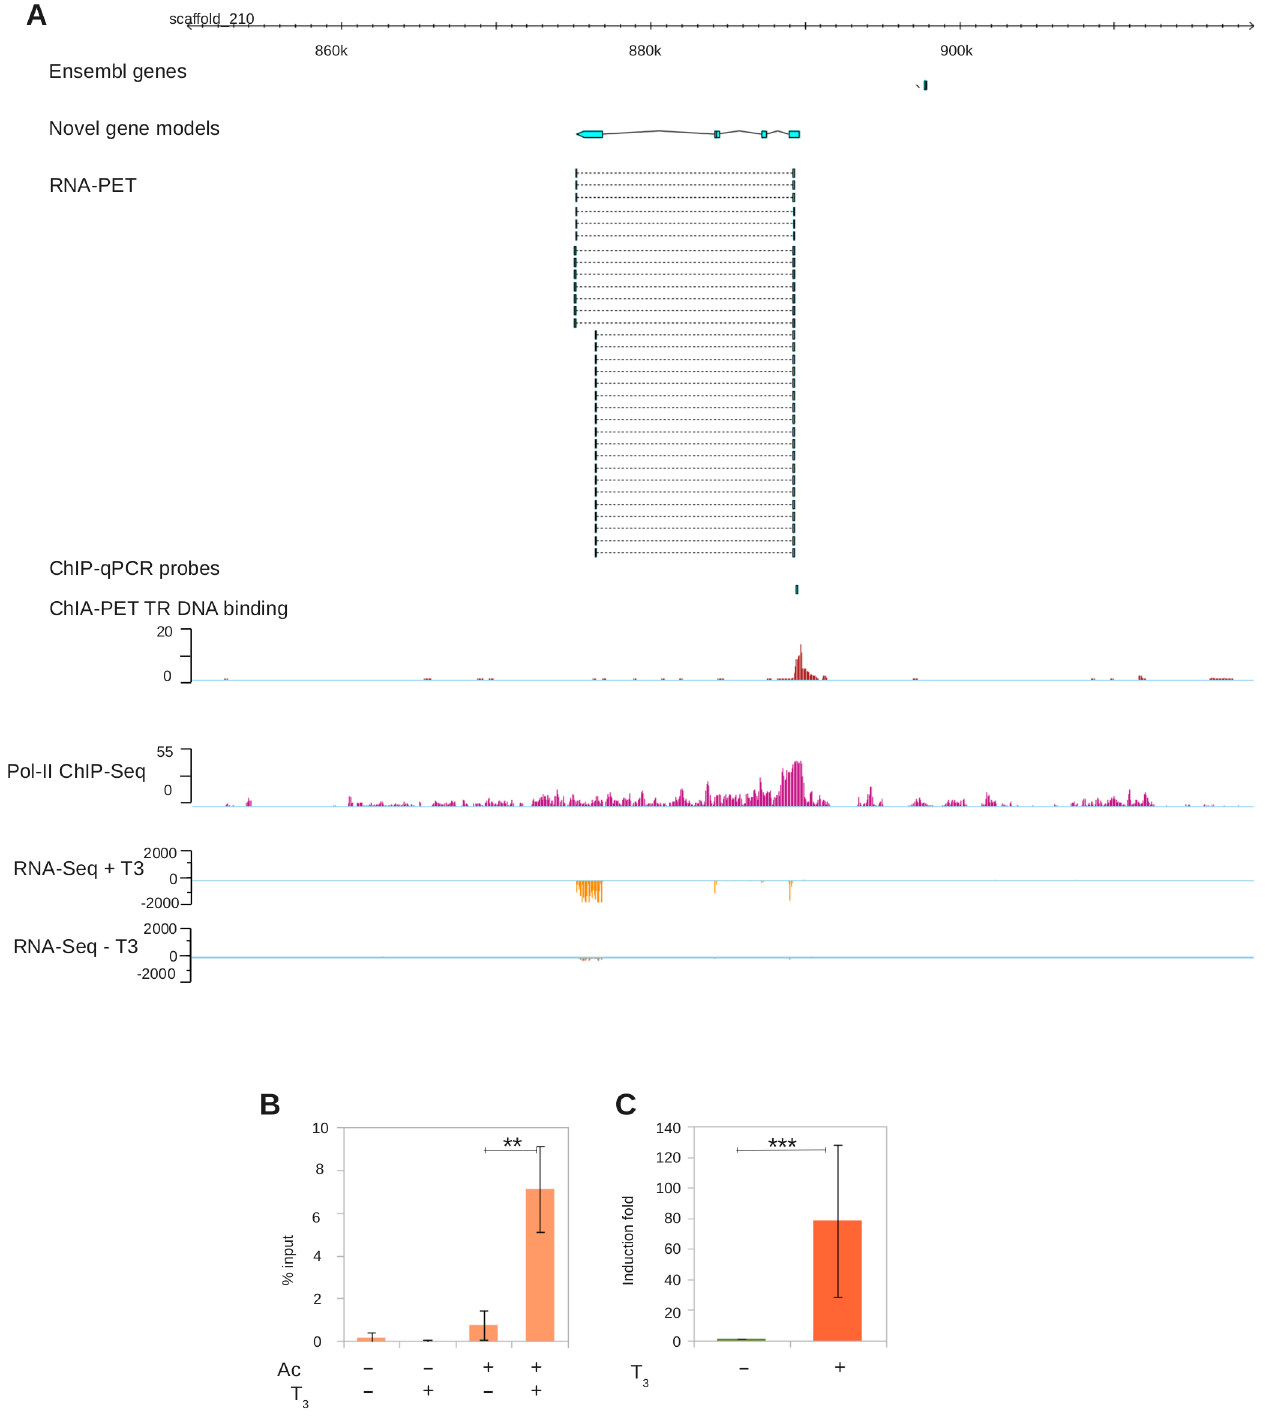
Fig 5. Benefit of genome re-annotation with RNA-PET for ChIA-PET analysis. A. Genomic view of an un-annotated gene. Track order: Ensembl genes, RNA-PET-based models, ChIA-PET TR binding density, RNA Pol-II binding density, RNA-Seq reads density with (+T 3 ) and without (-T 3 ) THs treatment. B. Close up of TR binding sites. Track order: Ensembl genes, RNA-PET-based genes, location of ChIP-qPCR probes, RNA-PET PETs, TR binding density and RNA Pol-II binding density. C: ChIP-qPCR validation of TR binding at locations shown in B. Ab: antibody, T 3 : 3 ’ ,5,3 ’ triiodothyronine treatment. D: Transcriptional induction assayed by